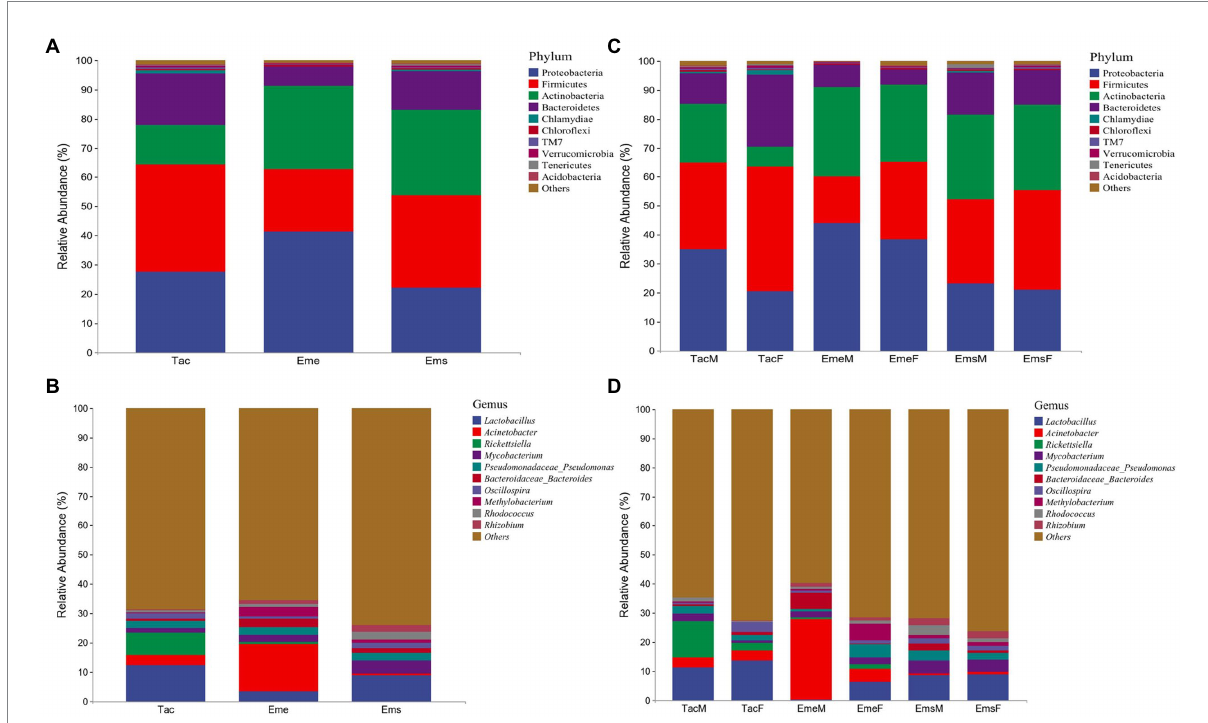
FIGURE 1 Relative abundance of major taxa in bird’s gut microbiota. The abscissa in each figure represents the respective group, and the ordinate shows the relative abundance of respective taxa at the classification level. (A) Relative abundances at the phylum level for the three migratory bird species; (B) Relative abundances at the phylum level between male and female individuals of the three bird species; (C) Relative abundances at the genus level for the three migratory bird species, and (D) Relative abundances at the genus level between male and female individuals of the three bird species. Tac, Tarsiger cyanurus ; Eme, Emberiza elegans ; Ems, Emberiza spodocephala ; TacM, T. cyanurus male; TacF, T. cyanurus female; EmeM, E. elegans male; EmeF, E. elegans female; EmsM, E. spodocephala male; EmsF, E. spodocephala